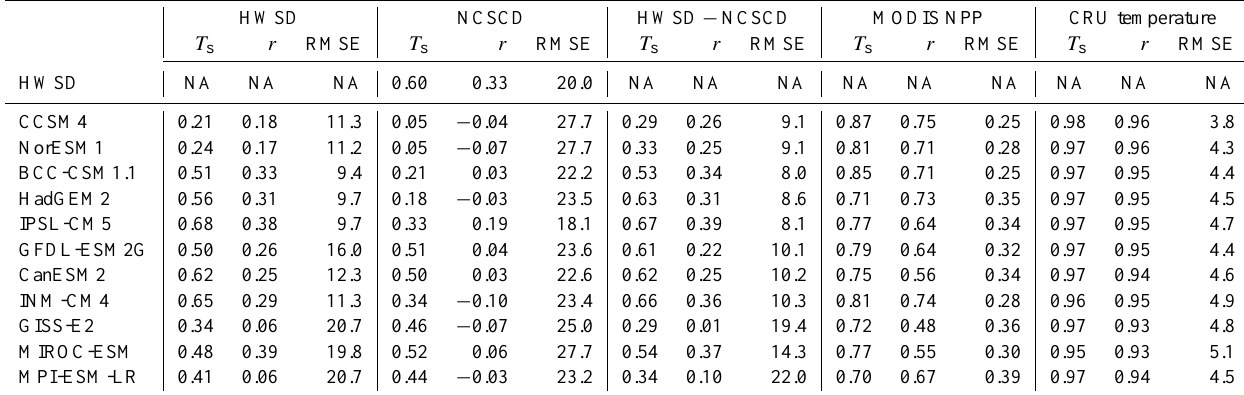
Table 3. Goodness-of-fit measures by grid cell for each ESM including soil carbon versus the HWSD, soil carbon versus NCSCD, soil